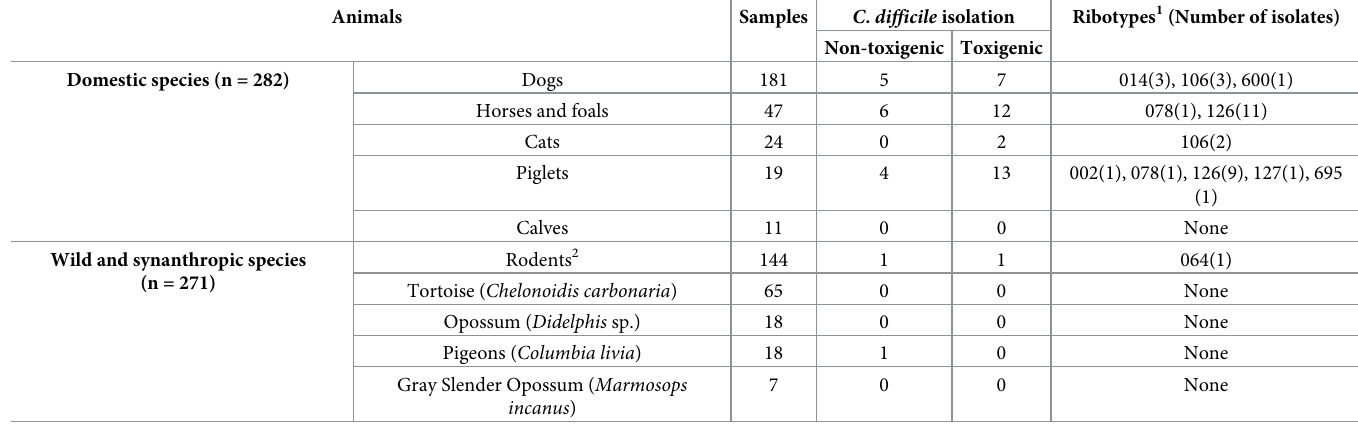
Table 2. Animal species samples (n = 544) included for Clostridioides ( Clostridium ) difficile detection between February 2018 and January 2020 at the laboratory of anaerobic bacteria from the veterinary university of Minas Gerais. Animals